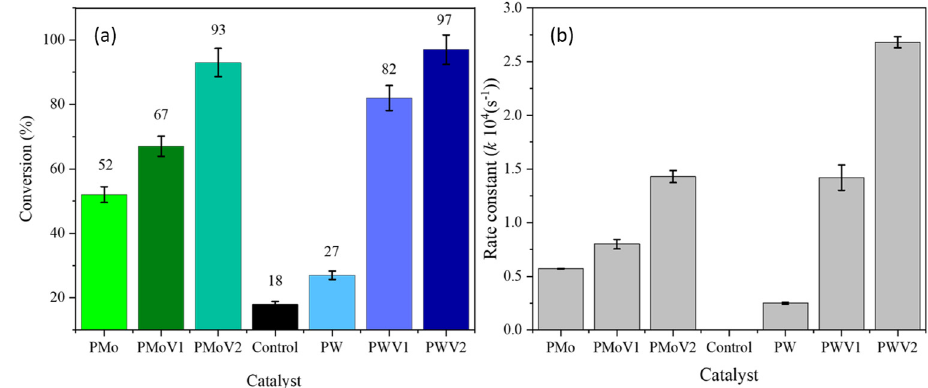
Figure 8. Total conversions ( a ) (%, color bars) and rate constants ( b ) (s − 1 , grey bars) of the liquid-